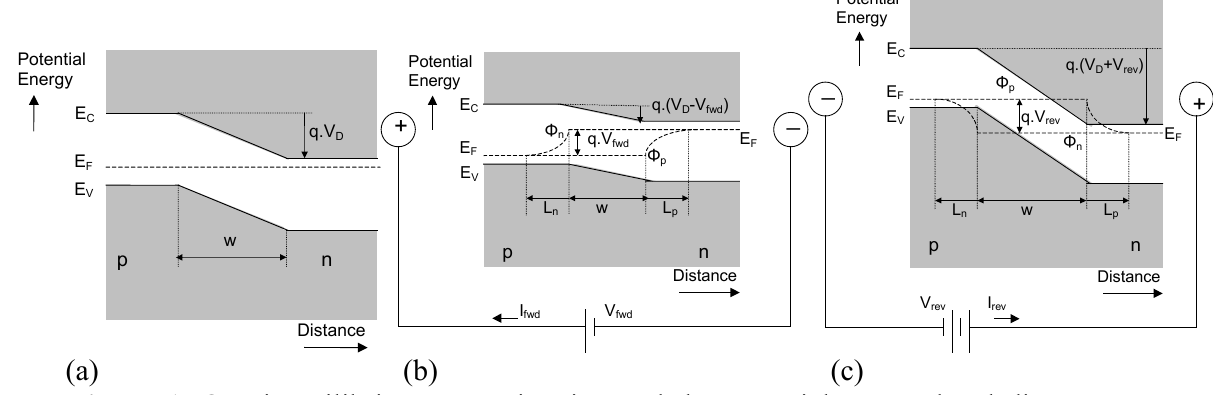
Figure 1. Quasi-equilibrium approximation and the potential energy band diagram as a function of distance for the case of a p-n junction (a) without externally applied bias, (b) , and (c) under reverse bias V . Symbol list: E is the bottom of under forward bias V fwd rev c the conduction band, E is the top of the valence band, Φ and Φ are the quasi-Fermi v n p levels for electrons and holes, E is the Fermi level at thermodynamic equilibrium, L and F n L are the minority carrier diffusion lengths for electrons and holes, V is the diffusion p D potential, w is the depletion layer width, q is the electronic charge and V is the TOTAL junction total potential due to the applied bias (after